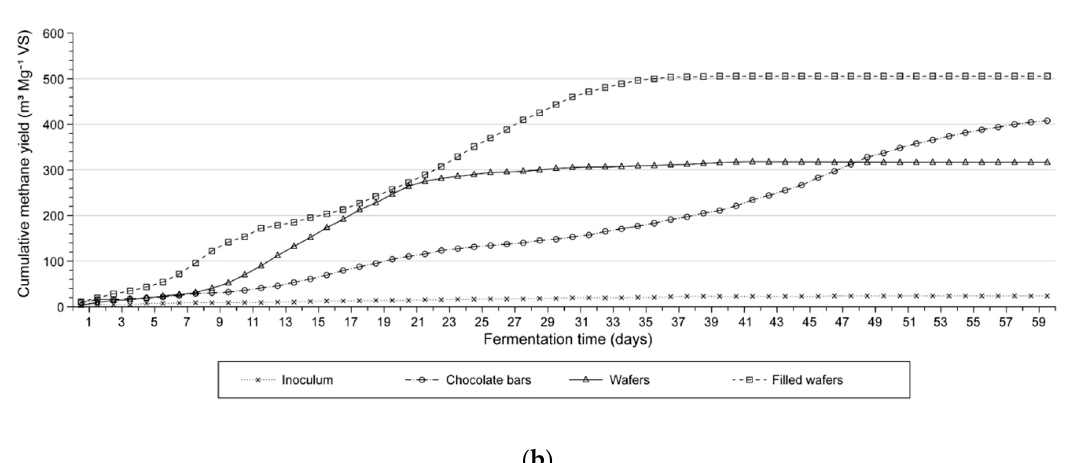
Figure 3. Cumulative yield of: ( a ) biogas and ( b ) methane from VS of inoculum, CB, W, and FW.